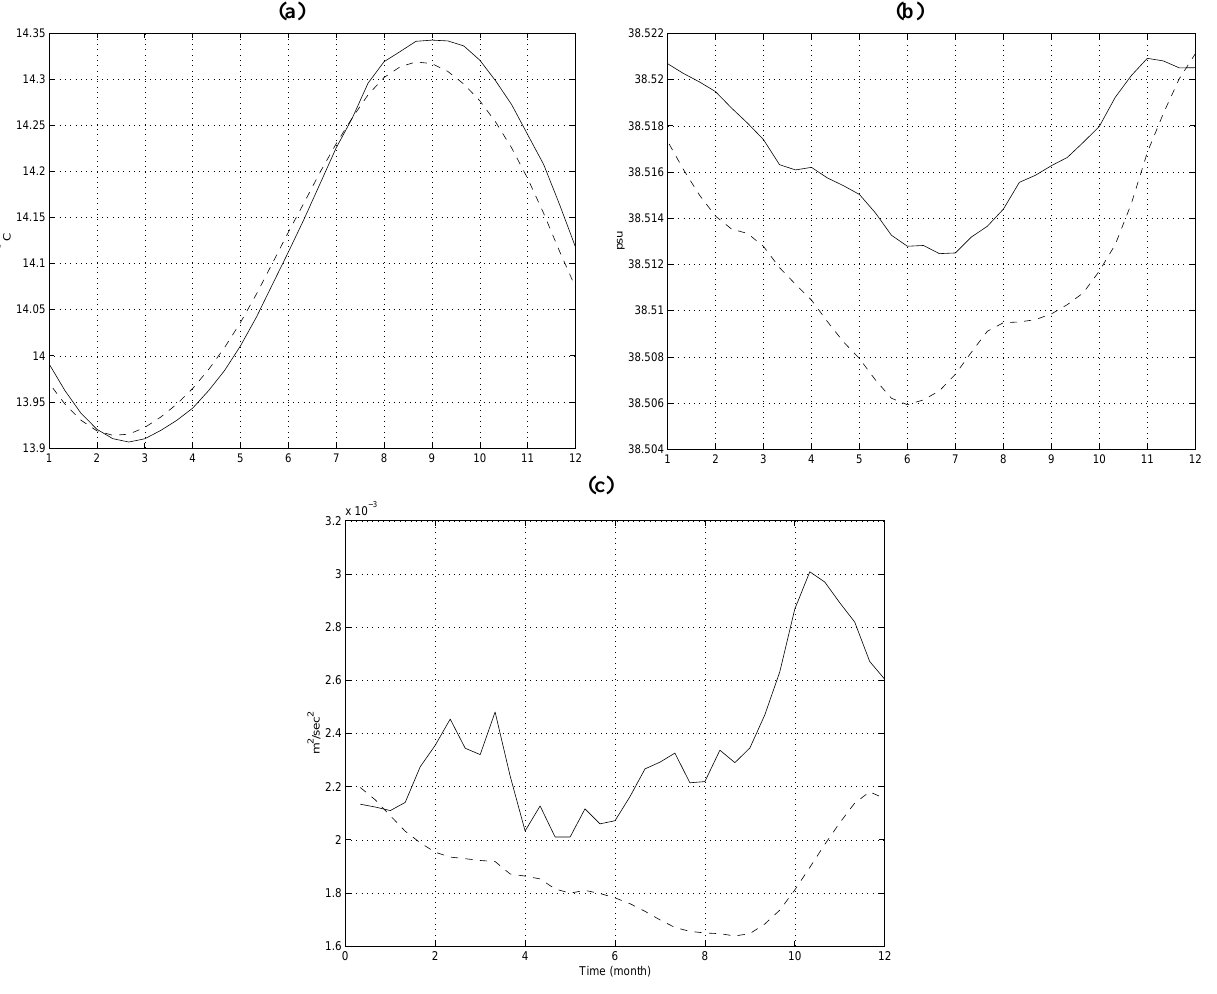
Fig. 9. Comparison between the fine resolution inner model (solid line) and the coarse resolution outer model (dashed line) by 10-day averaged time series of mean volume (a) temperature, (b) salinity and (c) total kinetic energy, calculated over the inner model domain during the last year of integration. Units are ◦ C, psu and m 2 /s 2 ,